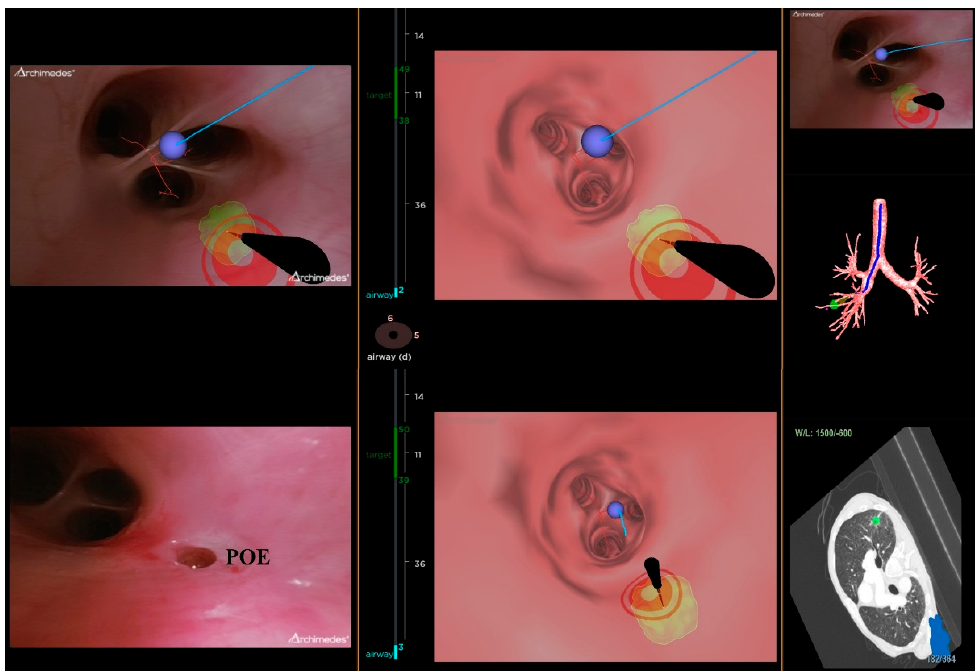
Figure 3. Archimedes virtual navigational bronchoscopy leading to the lesion.